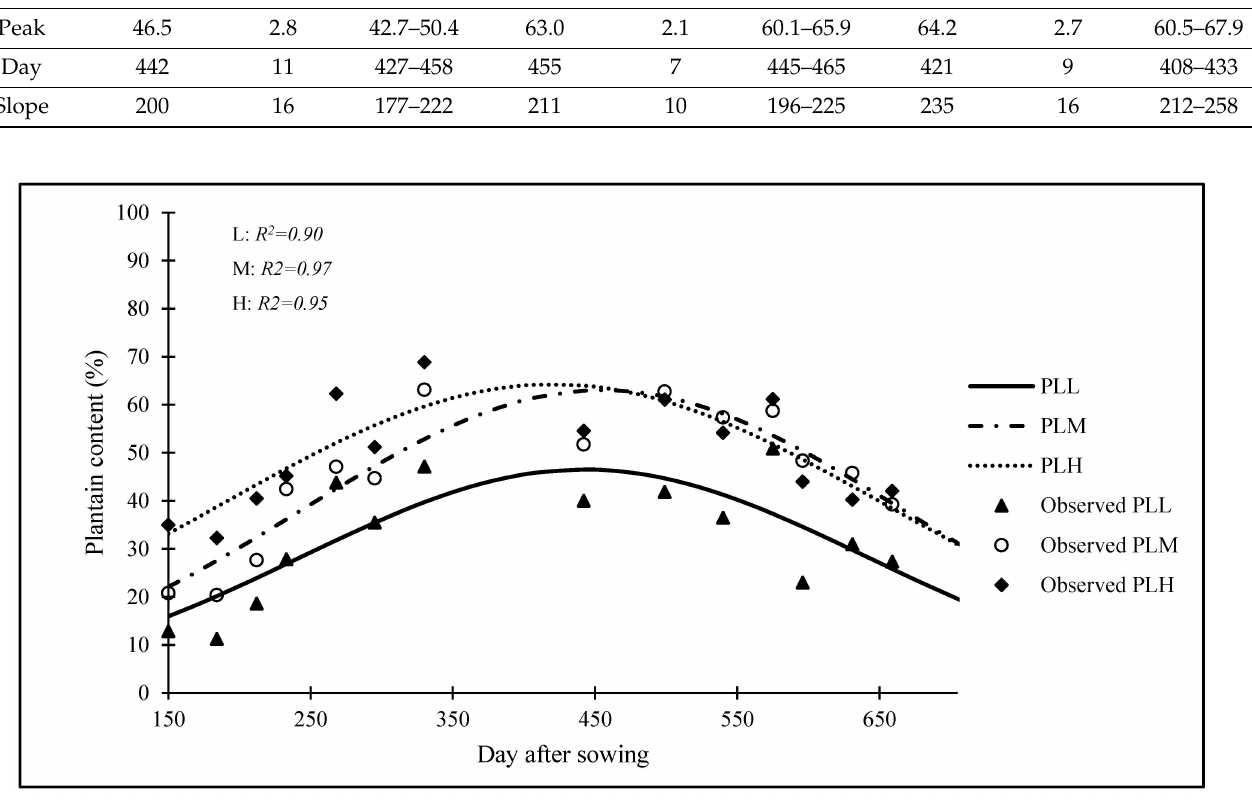
Figure 1. The modelled and observed percentage of plantain (leaves and reproductive stem) in PLL, PLM, and PLH from day 105 to 705 after